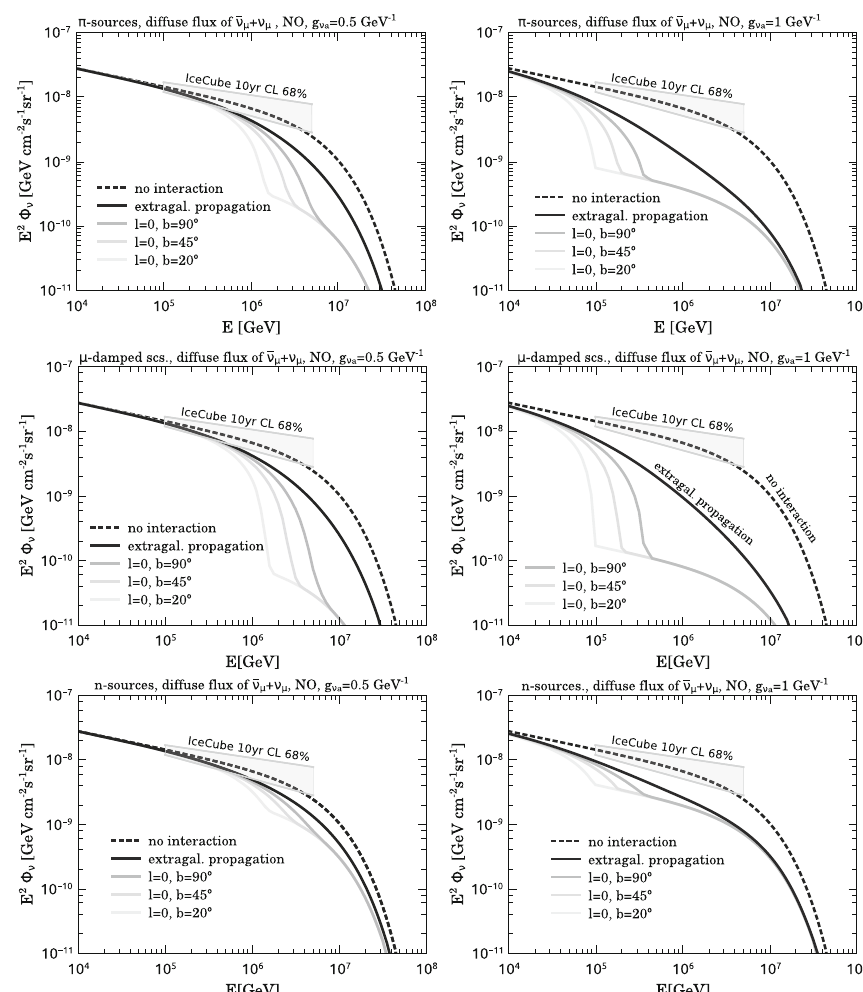
of the emitted flux would be more affected by